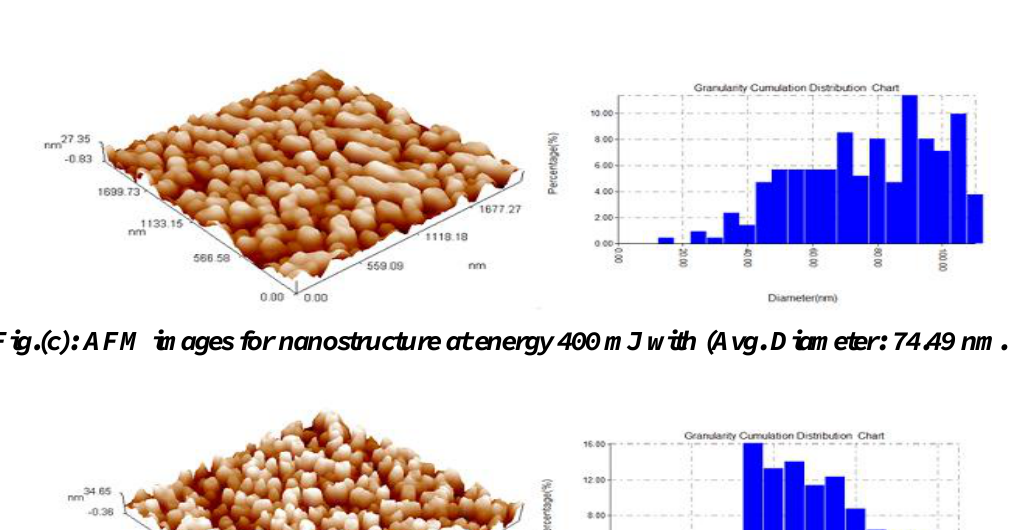
Fig.(b): AFM images for nanostructure at energy 300 mJ with (Avg. Diameter: 60. nm).